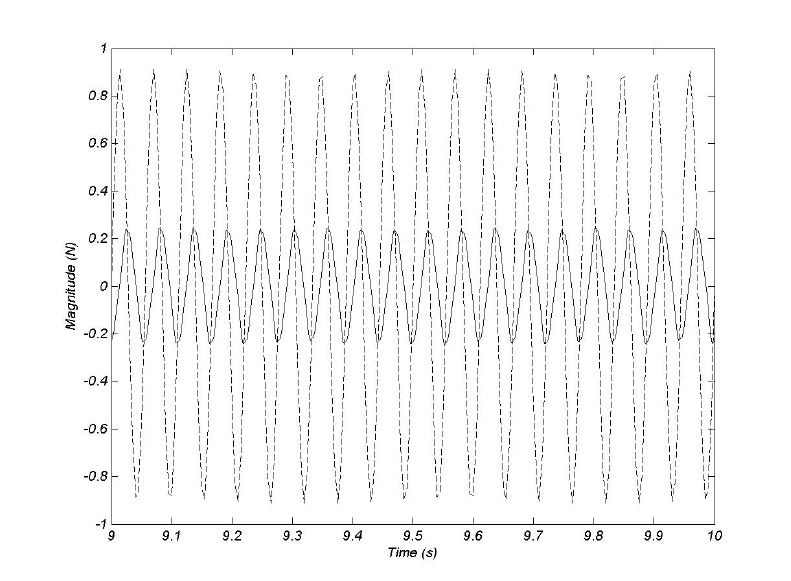
Fig. 19. Transmitted force variations of the system using the PD controller subjected to periodic engine disturbance at idling frequency at the final 1 seconds of the simulation. Open loop (–) and PD controlled